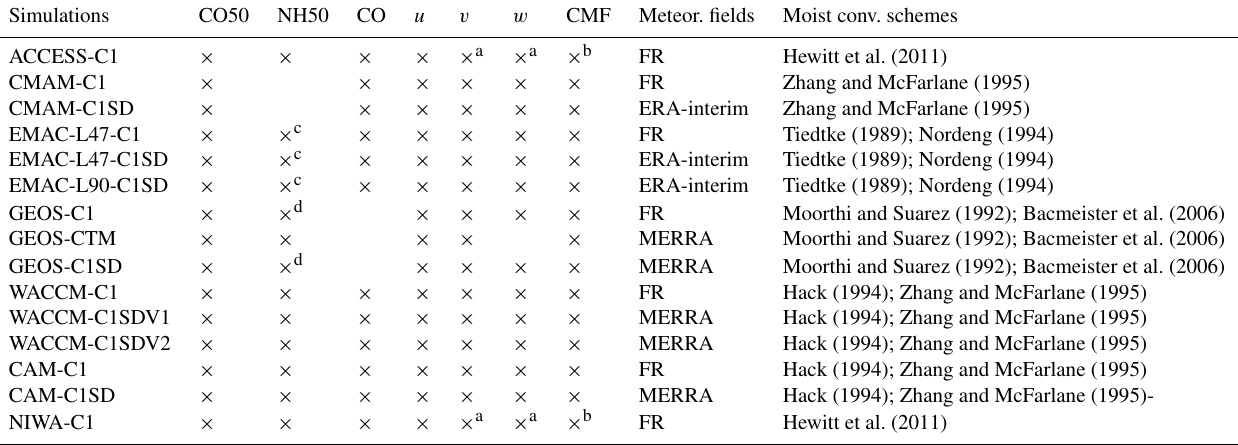
with the period of 01/2000–12/2009. c Simulations are based on the TA coordinates, but the meteorological fields have been particularly interpolated into the P coordinates with 31 levels. Table 2. Tracers and dynamical/thermodynamic variables of models analyzed in the study. u and v are the zonal wind and meridional wind; CMF is the convective mass flux by moist convection updraft. Available variables are marked by “ × ”. Variables of some simulations are scaled to make comparison of output variables commensurate between simulations and details are listed in table footnotes. (Re)analysis for specified dynamics in C1SD simulations is listed in the second to last column; otherwise the meteorology is free-running (FR) in C1 simula- tions. Moreover, meteorological fields are specified by nudging in most C1SD simulations, except GEOS-CTM uses CTM and GEOS-C1SD uses replay (a process involves reading in the analyzed field every 6h and recomputing the analysis increment using the same assimilation methods that produce the MERRA-2 reanalysis; see replay details in Orbe et al., 2017a). Nudging timescales vary among different modeling centers, and WACCM is the only model that has two simulations with different nudging timescales (i.e., 50h in WACCM C1SDV1 and 5h in WACCM C1SDV2). The moist convection scheme is listed in the last